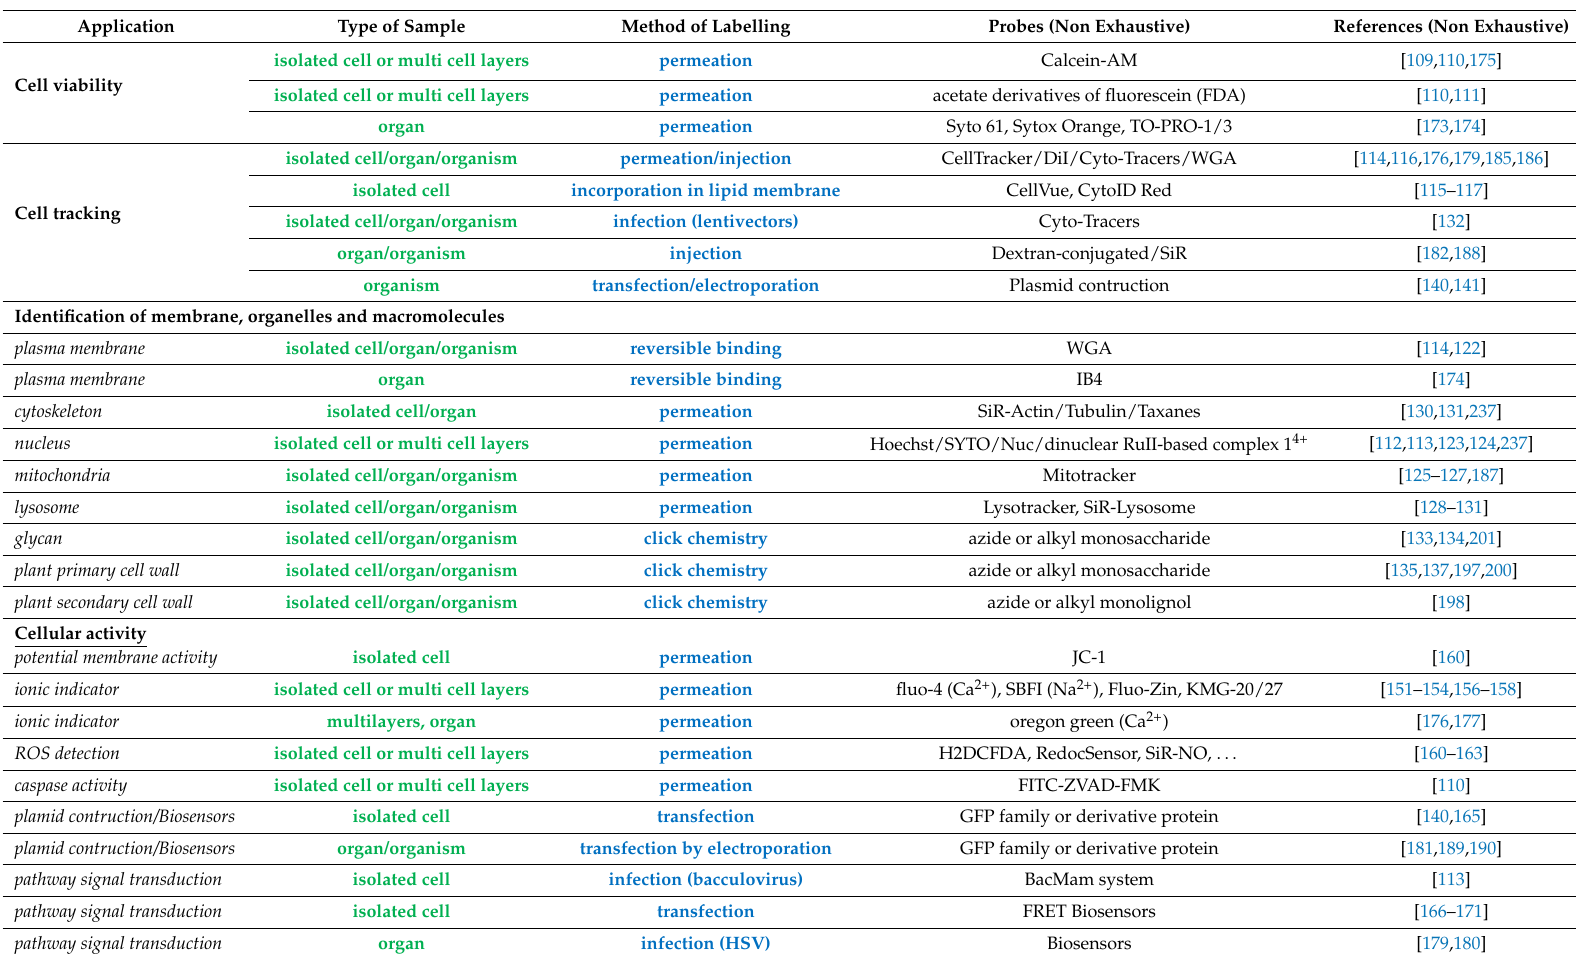
Table 1. Classification of fluorescent probes for live cell imaging with regard to their applications in different type of living